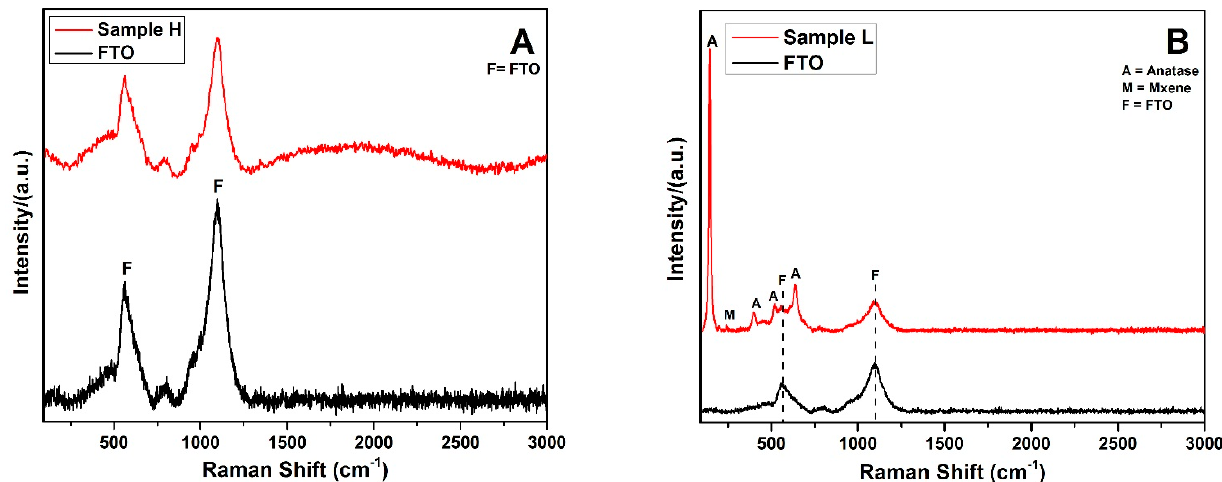
Figure 7. ( A ) Raman Spectra of FTO, Sample H; and ( B ) Raman Spectra of Sample L.